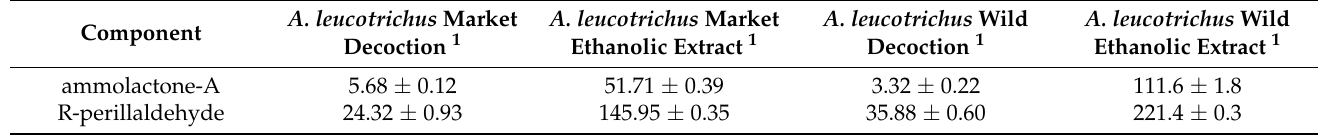
Table 6. HPLC-DAD quantitative analysis of fruits extracts of A. leucotrichus.